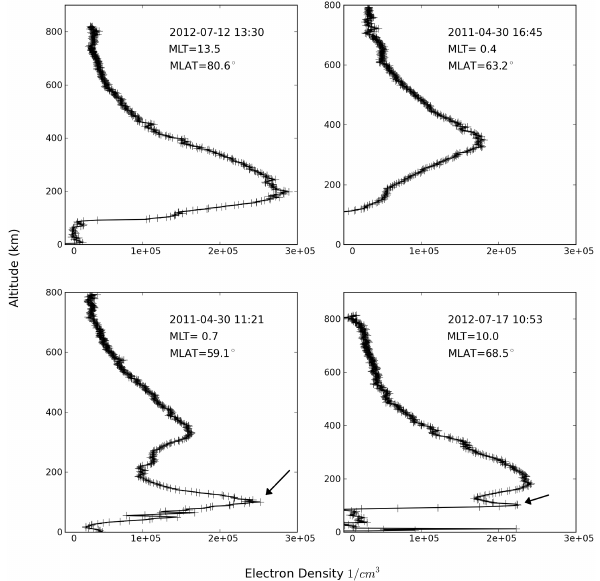
Figure 1. Four representative COSMIC electron density profiles from high latitude. Top: no electron density enhancements; bottom: electron density enhancements, assumed due to energetic particle precipitation, indicated by arrows.